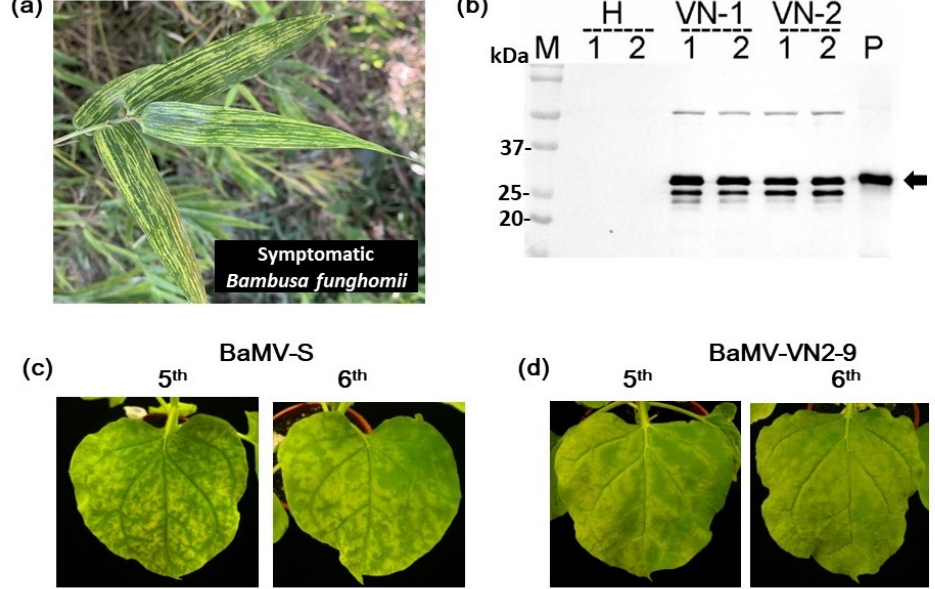
Figure 1. Symptoms on Bambusa funghomii and Nicotiana benthamiana caused by Bamboo mosaic virus (BaMV) Vietnam isolates. ( a ). Leaves of B. funghomii with severe mosaic symptoms in the bamboo plantations of Xuan Cam Commune, Hiep Hoa District, Vietnam, were presented. ( b ). Western blot analysis of the samples using specific antiserum against BaMV coat protein (CP). M, size marker; H, protein sample extracted from healthy N. benthamiana ; VN-1 and VN-2, samples from the two independent bamboo bushes, with 2 replicates; P, BaMV virion (50 ng) as the positive control. The expected position of BaMV CP is indicated by the arrow on the right. ( c , d ). Inoculation assays on N. benthamiana . The pKn-based [27] infectious clones of BaMV Vietnam isolates (six independent